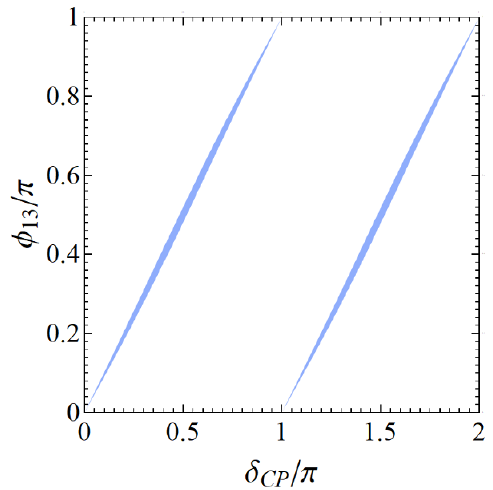
Figure 5 . Strong correlation between (cid:30) 13 and (cid:14) CP for the case of generalized e (cid:0) (cid:28) re(cid:13)ection in the charged lepton sector, assuming (cid:11) = (cid:13) = 0 and the three mixing angles in the experimentally preferred 3 (cid:27) regions [3].